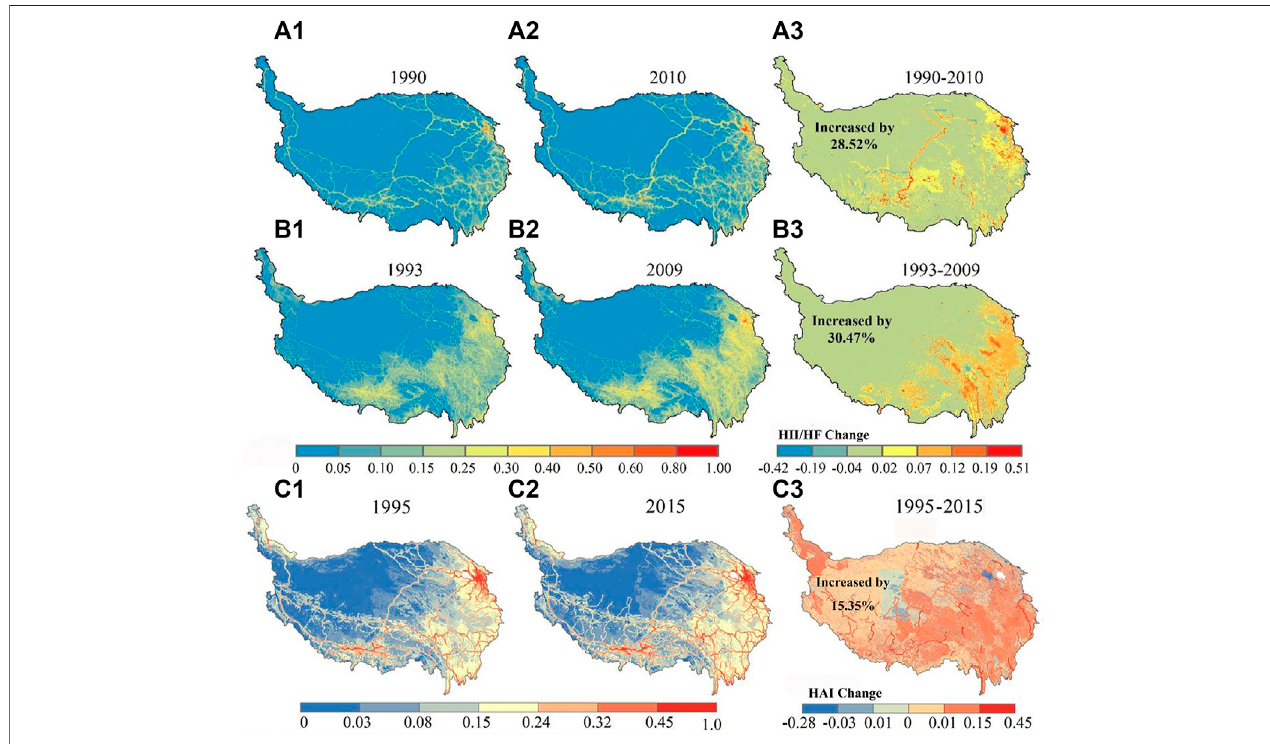
FIGURE 8 | Comparison of the human activity intensity results of different studies on the QTP. (A) The results of the global human footprint on the QTP (HF, 2009; Venter et al., 2016b); (B) the results of the human in fl uence intensity (HII, 2010; Li et al., 2018); (C) the results of the HAI map in this study.